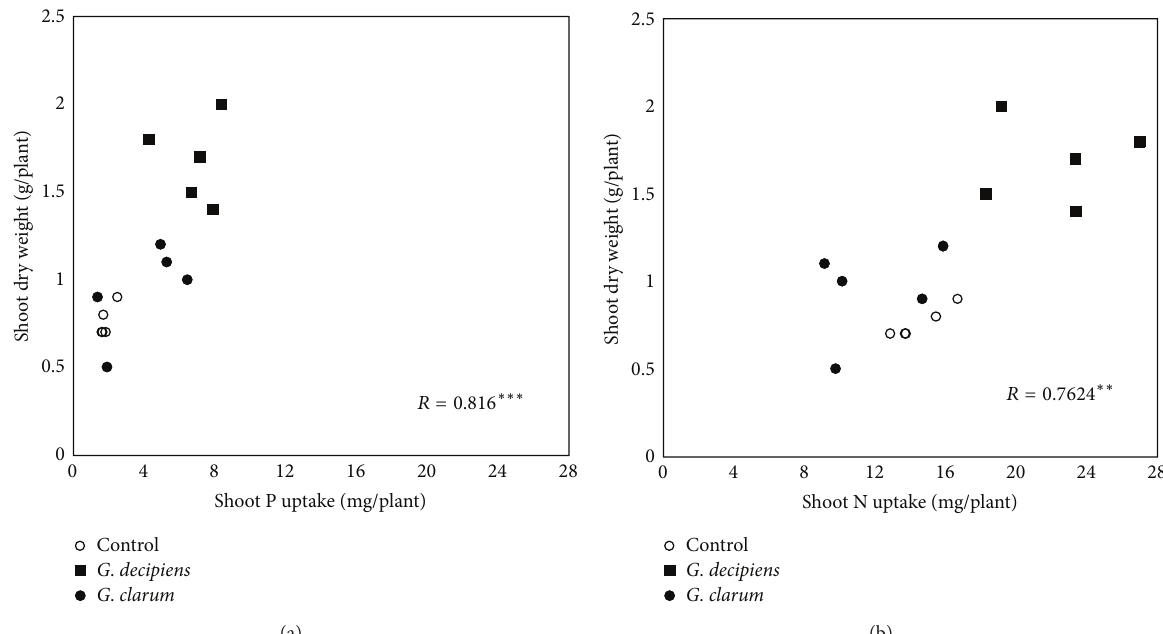
Figure 3: Correlation of shoot P uptake (a) and shoot N uptake (b) with shoot dry weight of M. paniculatus inoculated with AM fungi six months after sowing. Black squares: G. decipiens ; black circles: G. clarum ; white circles: control. ∗∗∗ 𝑃 < 0.001